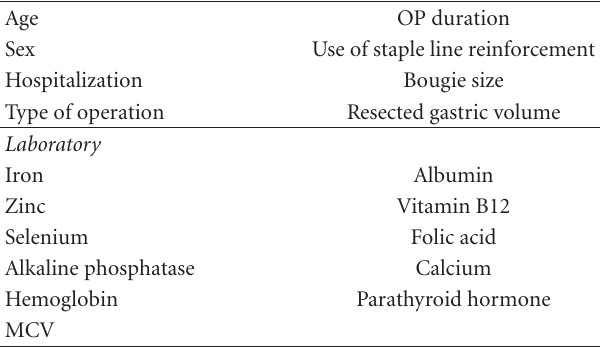
Table 1: Recorded